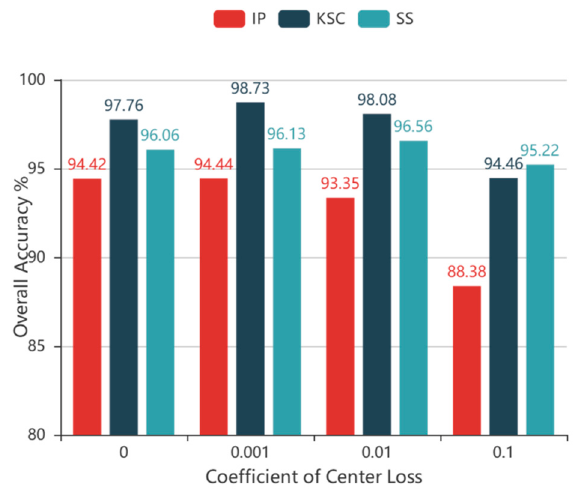
Figure 9. The overall accuracy of AUSSC for different center-loss coefficients.